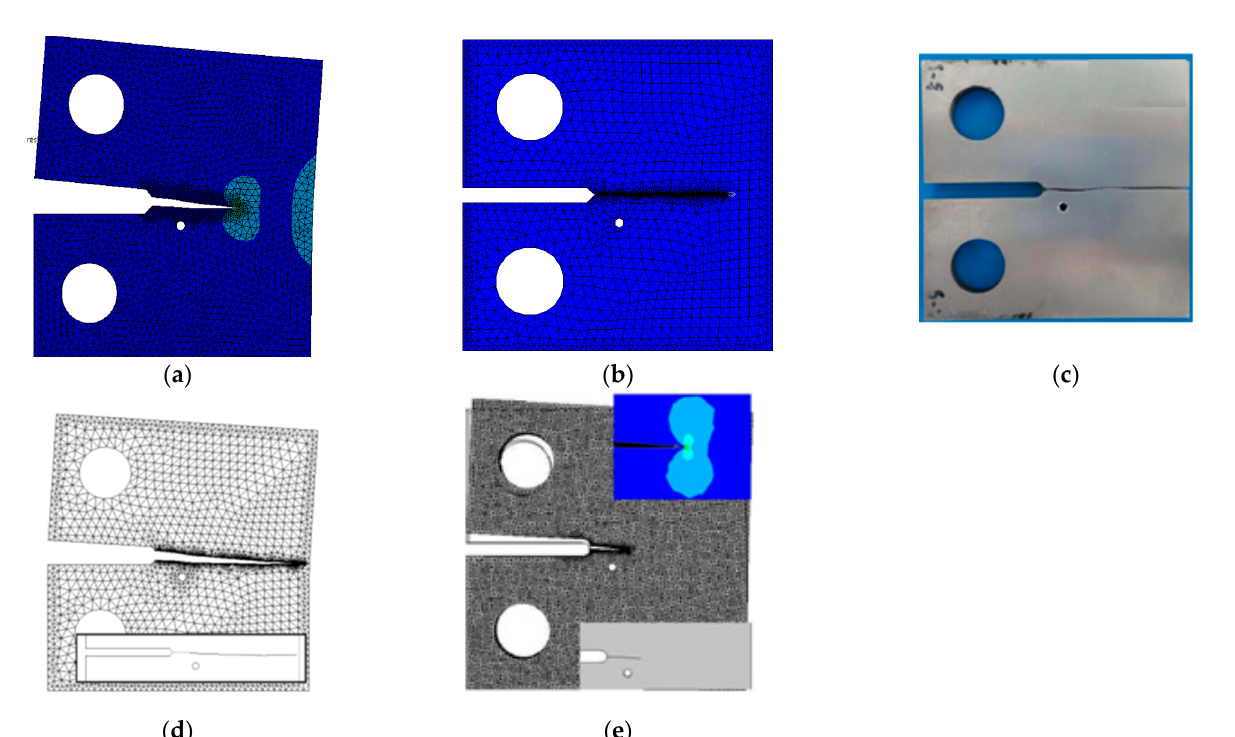
Figure 12. Predicted crack growth path for G5 specimen ( a ) ANSYS Workbench, ( b ) FRANC2D/L and ( c ) Experimental [32], ( d ) numerical [33], ( e ) FRANC3D [32].